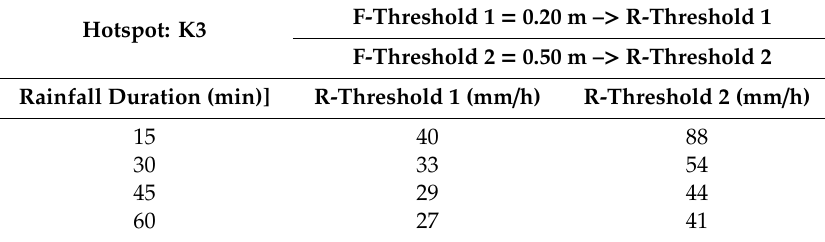
Table 1. R-thresholds calculated for hotspot K3.